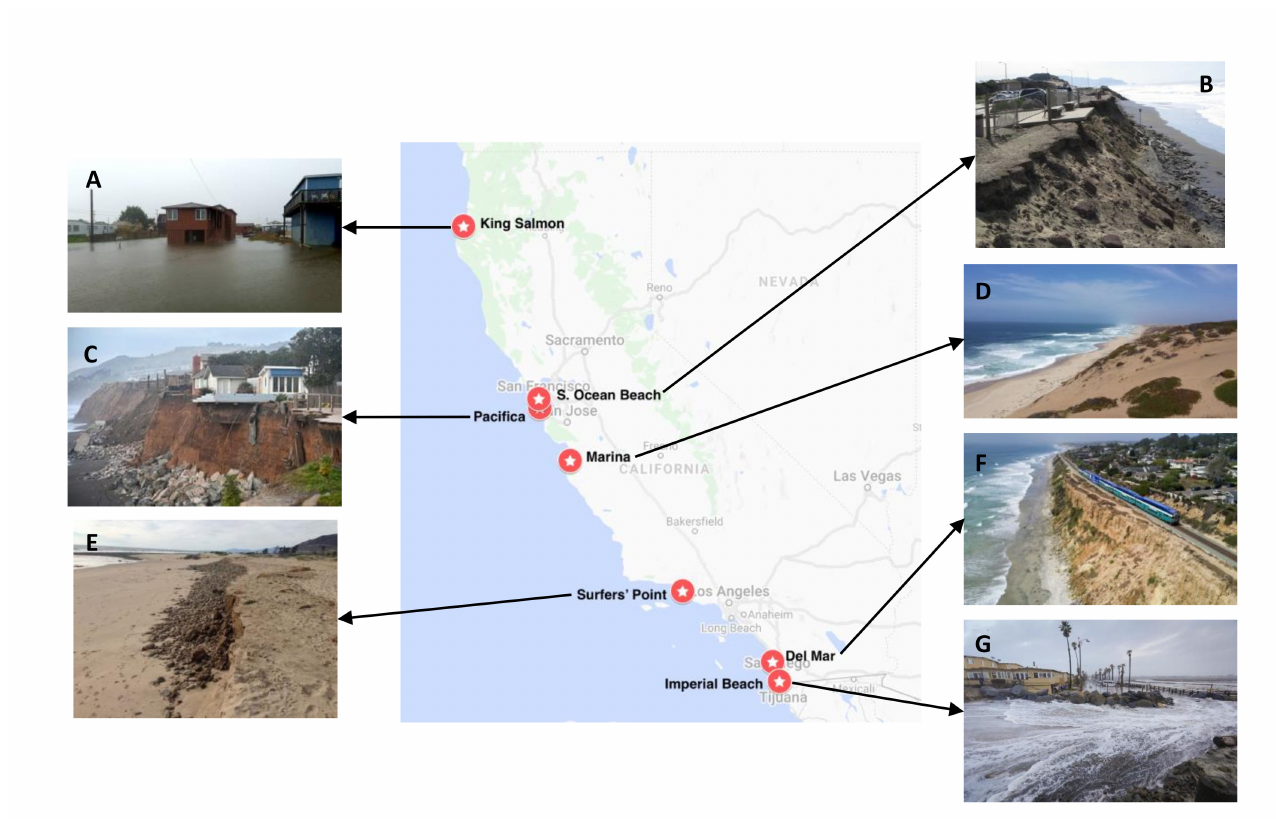
Figure 1. Locations and photographs of managed retreat case studies. ( A ) King Salmon (Photo: Kristina Kunkel) ( B ) South Ocean Beach (Photo: San Francisco Public Works 2014) ( C ) Pacifica (Photo: Josh Edelson/AFP via Getty Images) ( D ) Marina (Photo: CaliforniaBeaches.com) ( E ) Surfers’ Point (Photo: Paul Jenkin) ( F ) Del Mar (Photo: John Gibbins. Copyright © 2019 Los Angeles Times. Reprinted with permission) ( G ) Imperial Beach (Photo: Howard Lipin. Copyright © 2019 Los Angeles Times. Reprinted with